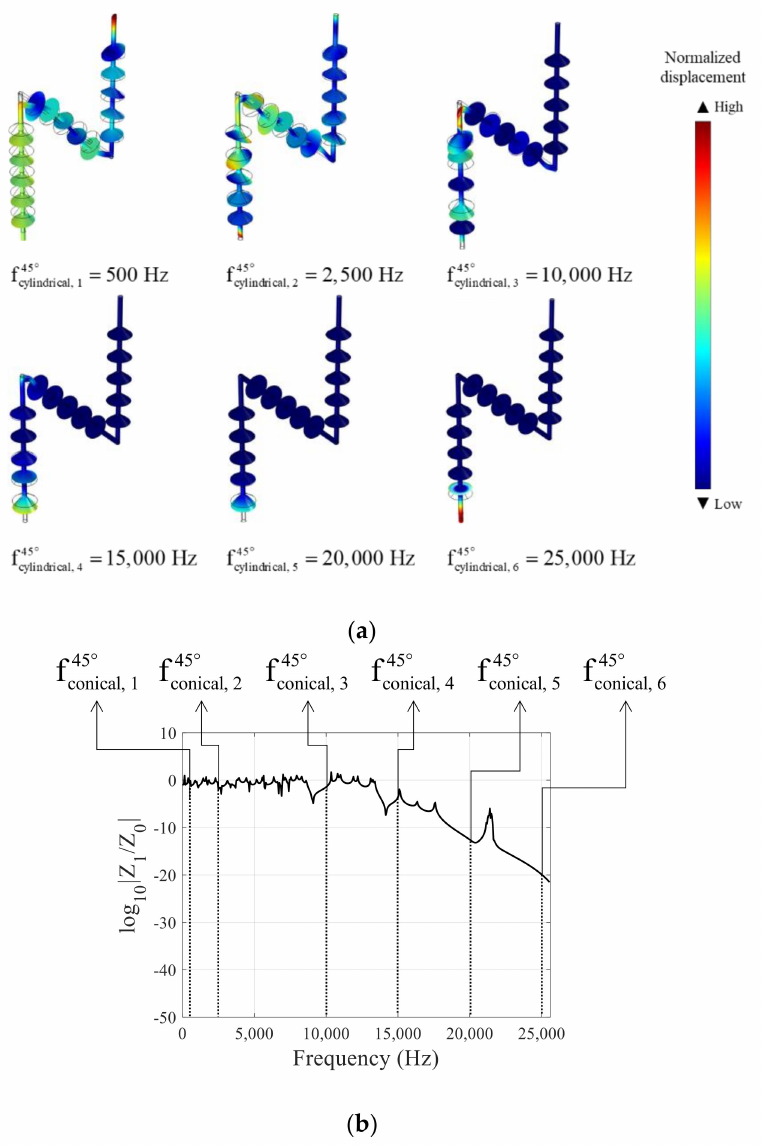
Figure 16. ( a ) Displacement at certain frequency of the conical metamaterials and ( b ) the frequency responses ( θ = 30 ◦ ).